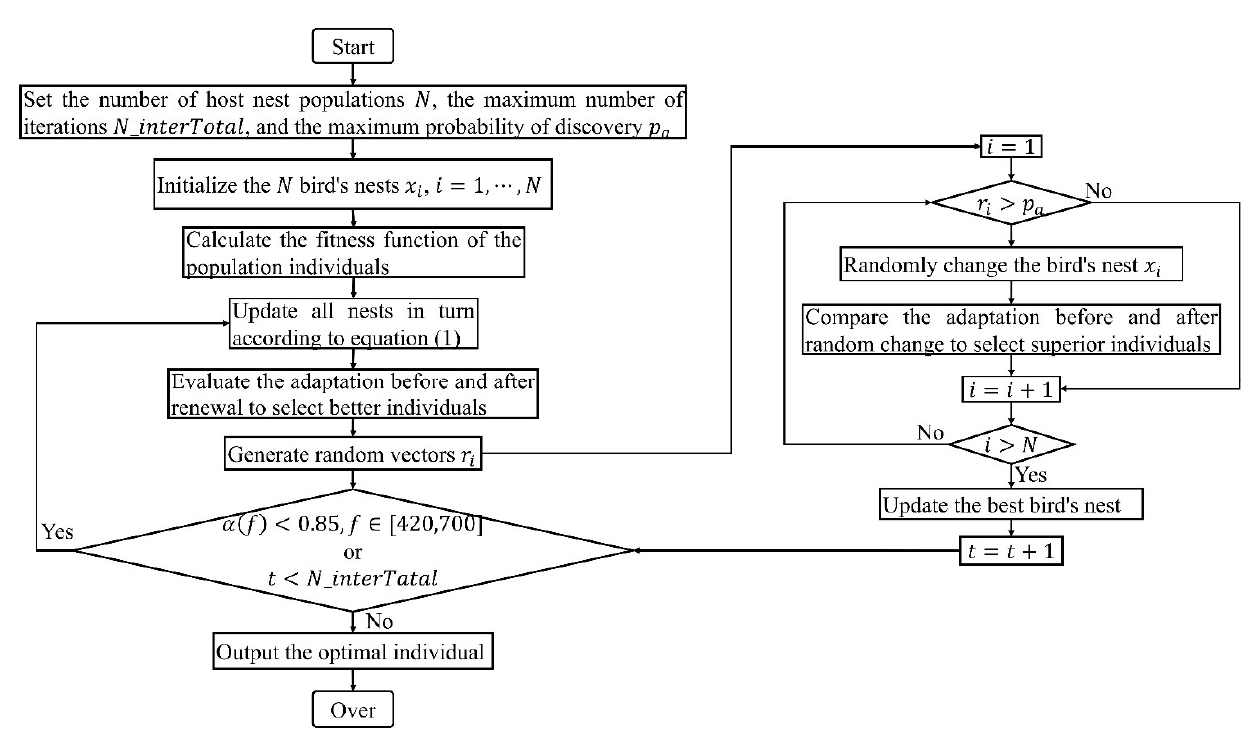
Figure 5. The optimization process of cuckoo search algorithm for the acoustic metamaterial of multiple parallel hexagonal Helmholtz resonators.